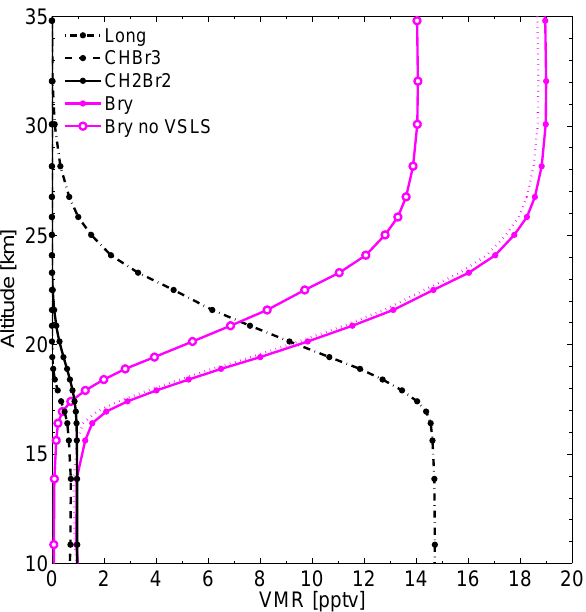
Fig. 6. Relation between available ice particle surface area density in a model box and the resulting fraction of adsorbed HBr on ice to total HBr derived from Eq. (1) (blue line, left ordinate). The red bars indicate the relative frequency of occurrence of surface area density values in the tropical tropopause (20 ◦ N to 20 ◦ S, 330K to 380K) for 2006 of the full chemistry run (right ordinate). The fraction of adsorbed HBr is lower than 46% in 95% of all calculated surface area densities. Table 3. Gas phase reactions in the full chemistry setup that lead to the formation/destruction of HBr and the corresponding rate con- stant k(T ) obtained from the JPL recommendations (Sander et al., 2006). The reactions denoted by ∗ are not included in the stan- dard setup. Sensitivity calculations have shown that these reactions do not significantly affect the amount of HBr in the UTLS in our